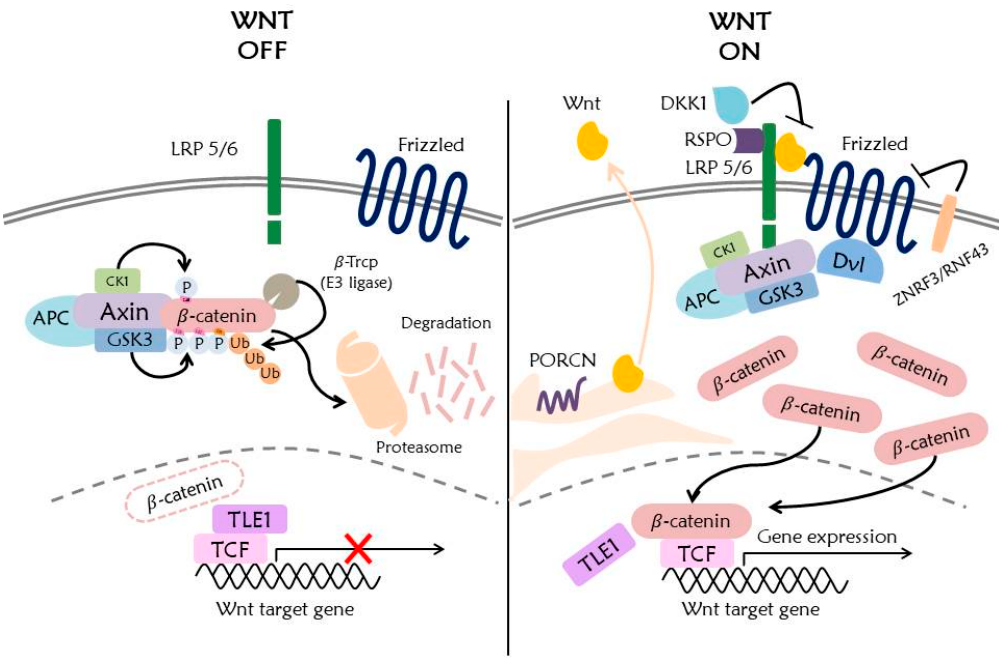
Figure 1. Overview of the Wnt / β -catenin signaling pathway. Without Wnt protein, β -catenin is phosphorylated by a destruction complex including Axin, CK1, GSK3, and APC. Phosphorylated β -catenin is ubiquitinated by β -Tcrp E3 ligase and is degraded by the 26S proteasome. Decreased translocation of β -catenin into the nucleus inhibits the expression of Wnt target genes. With Wnt protein, a destruction complex binds to activated Wnt receptor, resulting in inhibition of phosphorylation and ubiquitination of β -catenin, and subsequent translocation of β -catenin into the nucleus. Binding of β -catenin to TCF induces the expression of the Wnt target genes. In the canonical Wnt signaling pathway, a low-density lipoprotein receptor-related protein 5/6 (LRP5/6), Frizzled receptor (Fz), Disheveled (Dvl), β -catenin, Glycogen Synthase Kinase 3 (GSK3), Casein Kinase 1 (CK1), Axin, Adenomatous polyposis coli (APC), and DNA-bound T cell